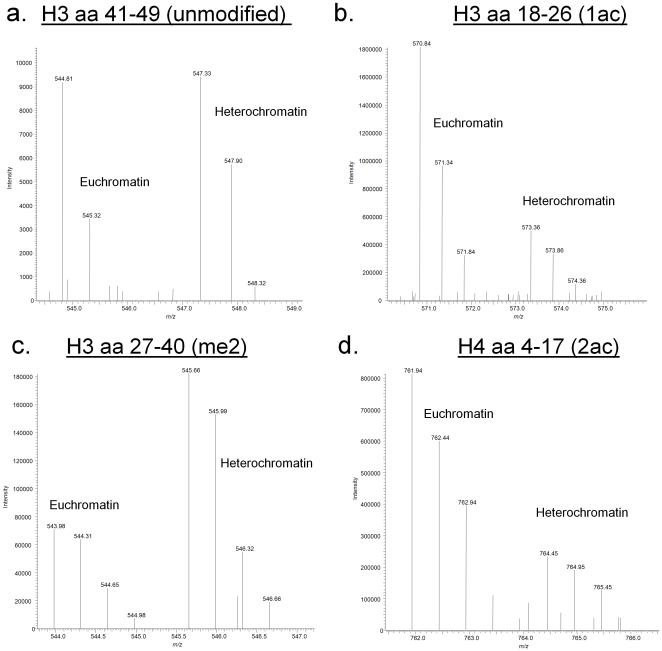
Quantitative comparison of selected histone PTMs in euchromatin (d0-labeled) and heterochromatin (d5-labeled).(a.) Full mass spectrum for the 2+ charge state of an intrinsically unmodified H3.1 peptide (aa 41–49), (b.) Full mass spectrum for the 2+ charge state of a monoacetylated H3.1 peptide (aa 18–26, H3K18), (c.) Full mass spectrum for the 3+ charge state of the H3.1 dimethylated peptide (aa 27–40, H3K36), (d.) Full mass spectrum for the 2+ charge state of a diacetylated H4 peptide (aa 4–17) Labels specify the fraction represented by each peak. m/z values are indicated for each peak.